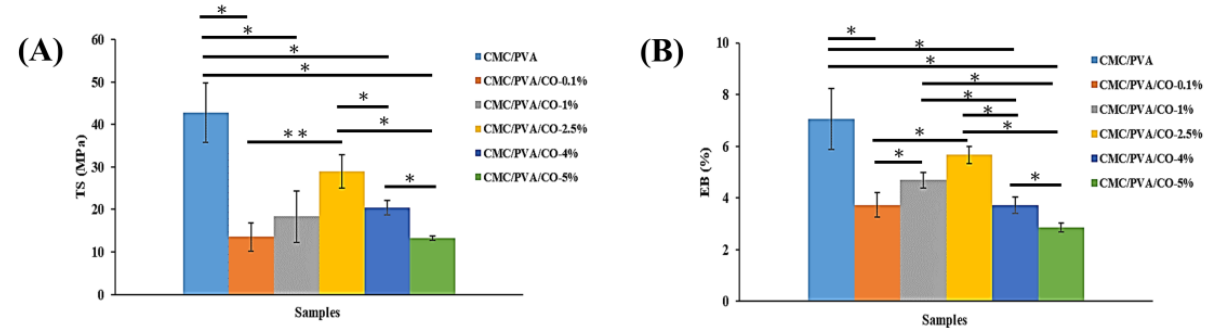
Figure 4. Mechanical properties of CMC/PVA/CO composite films with different CO concentrations (0.0%, 0.1%, 1%, 2.5%, 4%, and 5%): ( A ) tensile strength, ( B ) elongation at break rate. Results are expressed as mean ± standard deviation and statistical significance is represented as (*) p < 0.05 or (**) p < 0.01.